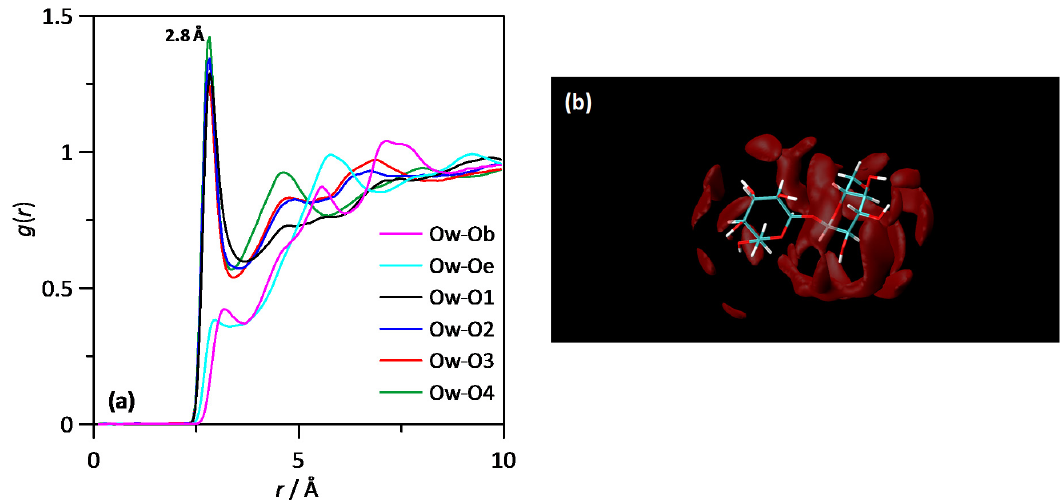
Figure 7. ( a ) Site-site radial distribution functions, g ( r ), for the reported atomic pairs; ( b ) spatial distribution functions of oxygen atoms in water (Ow) around THAL molecule. All the results reported for ω THAL + (1- ω ) water mixture ( ω = 0.240) at 310 K. Atom labelling as in Figure 1.